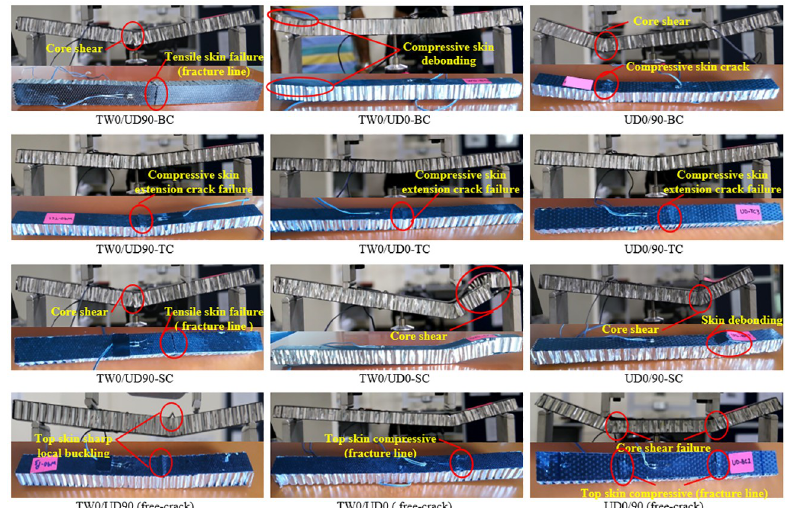
Fig 9. The typical failure mode of crack-free SHC beam specimens and those containing 10 mm skin crack.